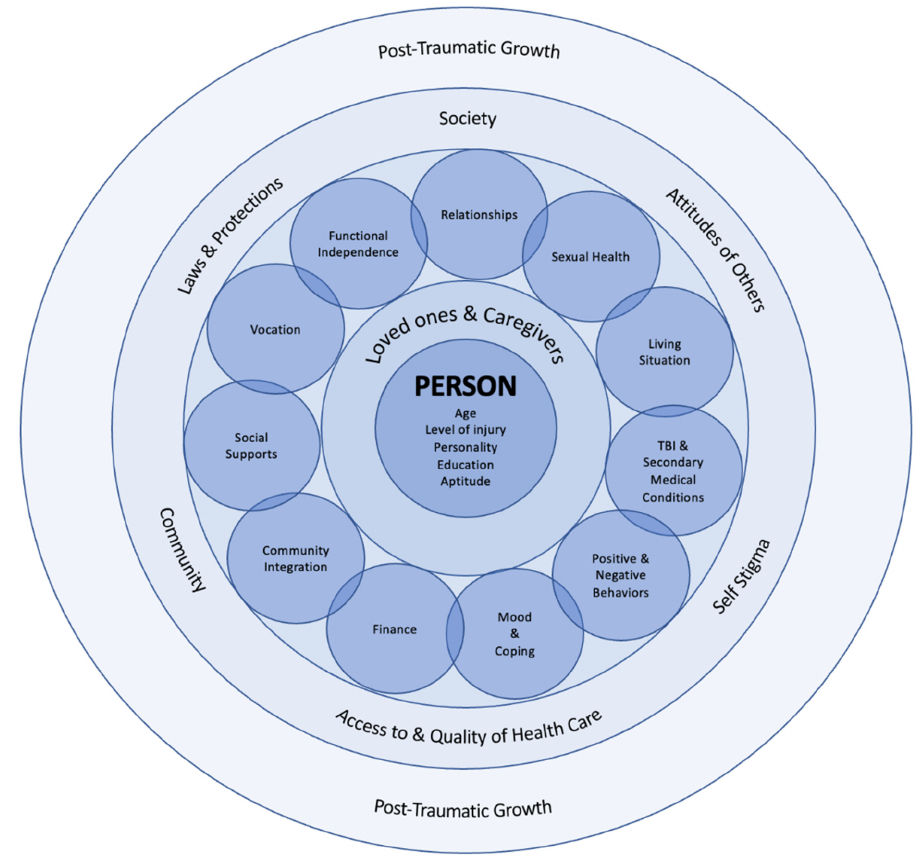
Figure 2. Model illustrating some of the psychosocial consequences a person experiences after acquiring SCI.